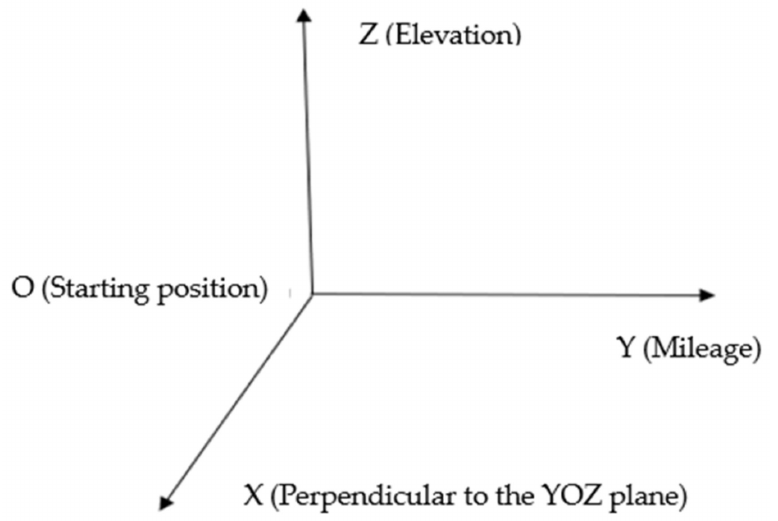
Figure 1. The relative coordinate system of point cloud